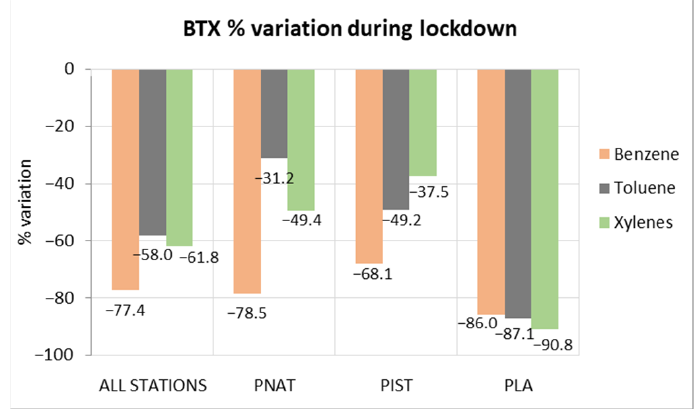
Figure 8. % Variation of BTX for all stations considered.